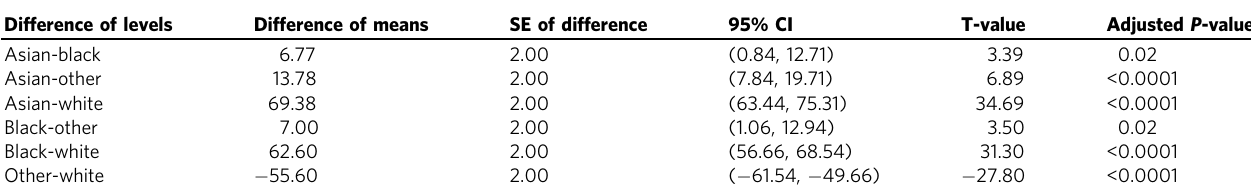
Table 2 Tukey simultaneous tests for differences of